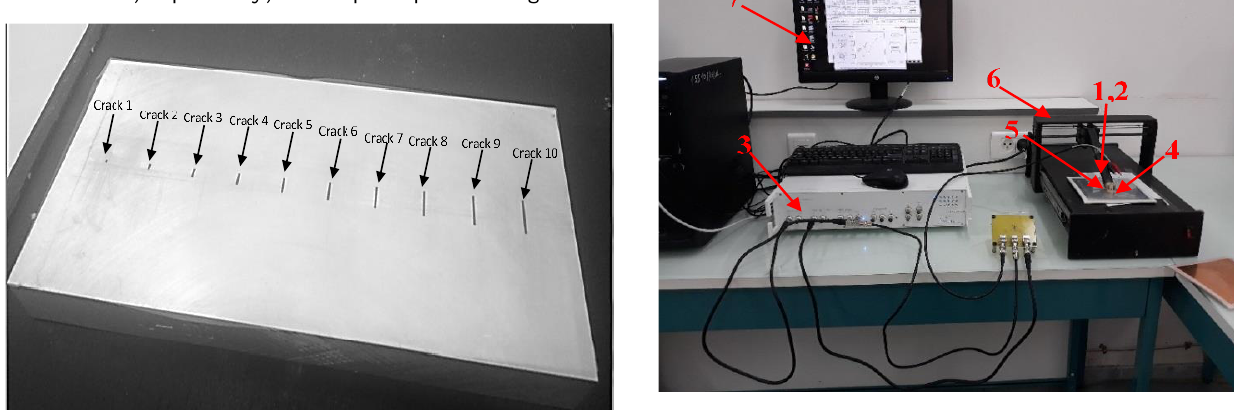
FIGURE 7. Measuring System. 1- Sensor (Ferrite Coil), 2- Sensor (Giant Magnetoresistance), 3- Lock-in Amplifier HF2LI, 4- Test Sample, 5- Cracking Opening, 6- Sensor Displacement System,7-